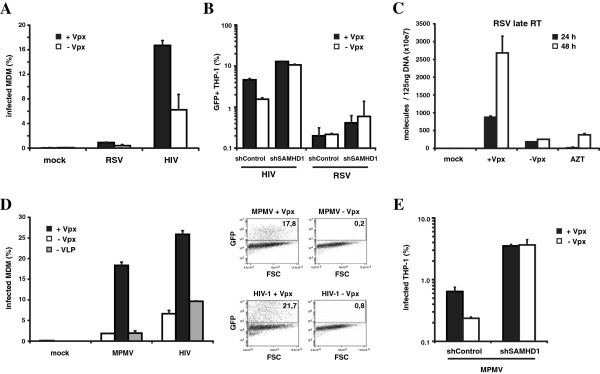
SAMHD1 restricts MPMV and RSV. (A) MDM or (B) PMA-treated THP-1 shControl and THP-1 shSAMHD1 cells were preincubated with Vpx-containing (+Vpx) or control VLP (−Vpx) and infected with control supernatant (mock) or with RSV-GFP or HIV-GFP reporter viruses at a MOI = 1. Reporter gene expression in infected cells was analyzed three days postinfection by flow cytometry. (C) MDM were incubated with Vpx-containing (+Vpx) or control VLP (−Vpx) and then infected with control supernatant (mock) or with RSV reporter virus. Cellular DNA was purified 24 and 48 h postinfection and used to quantify late reverse transcription products by qPCR. AZT was added to one well treated with Vpx-containing VLP prior to infection (AZT). (D) MDM were preincubated for 2 h with Vpx-containing (+Vpx) or control VLP (−Vpx) and not infected (mock) or infected with MPMV-GFP or HIV-GFP at a MOI = 1. The data are shown on the left as a histogram and on the right as a FACS plot. (E) MPMV infection as in (D) but using PMA-differentiated THP-1 shControl and THP-1 shSAMHD1 cells. Reporter gene expression was analyzed three days postinfection by flow cytometry. Reporter gene expression was analyzed as shown for HIV-GFP and MLV-GFP infection of MDM blotted in (D). The data presented are the average of triplicates with error bars indicating the standard deviation. The results of one of three independent experiments are shown.